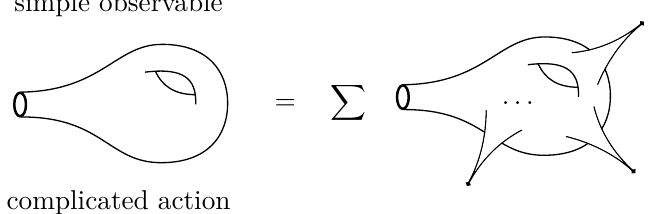
Figure 3 . Open-closed duality in a nutshell. Here we have in mind computing V 1 , 1 ( b ) in the theory with an exponential of τ k inserted in the action, see (5.9) below. Either we use the complicated action (5.9) (left); or we expand out the deformations (right), in which case we have a sum over cusp-defects but we just use the simple JT gravity action at the cost of computing a more complicated observable with many boundaries (or operators). Alternatively, in the context of this section, we could think of the left picture as JT gravity and the right picture as Airy with an exponential of (4.19) inserted. The idea is always the